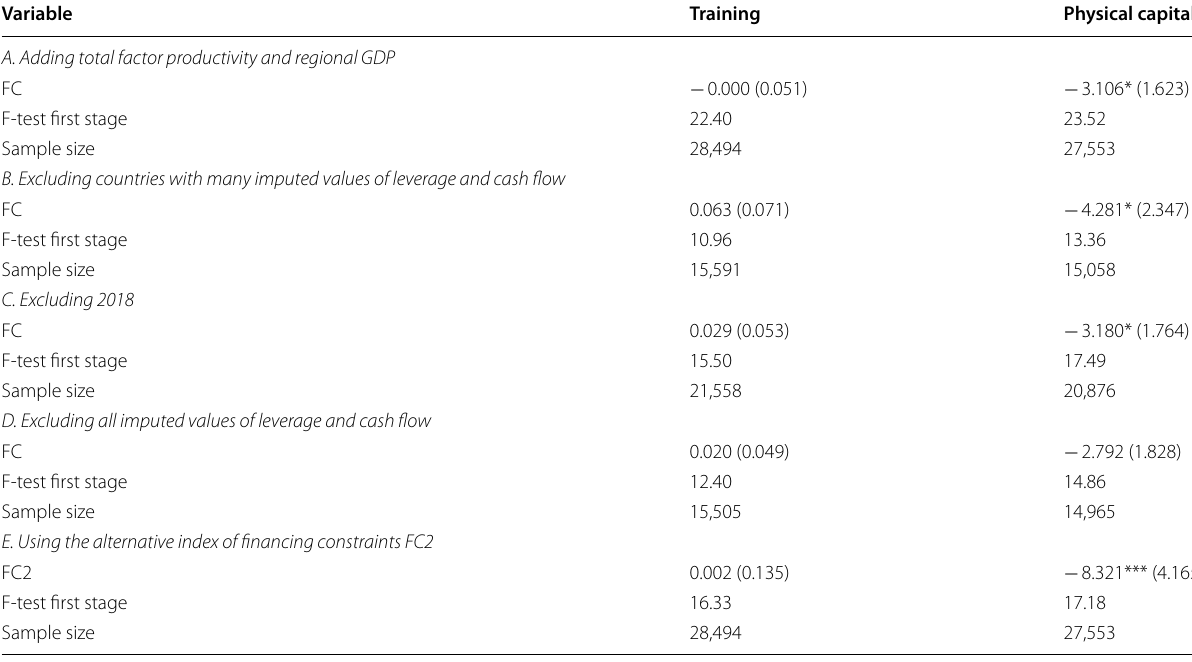
Table 7 The effect of the financing constraints index (FC) on investment in training per employee (TI) and physical capital